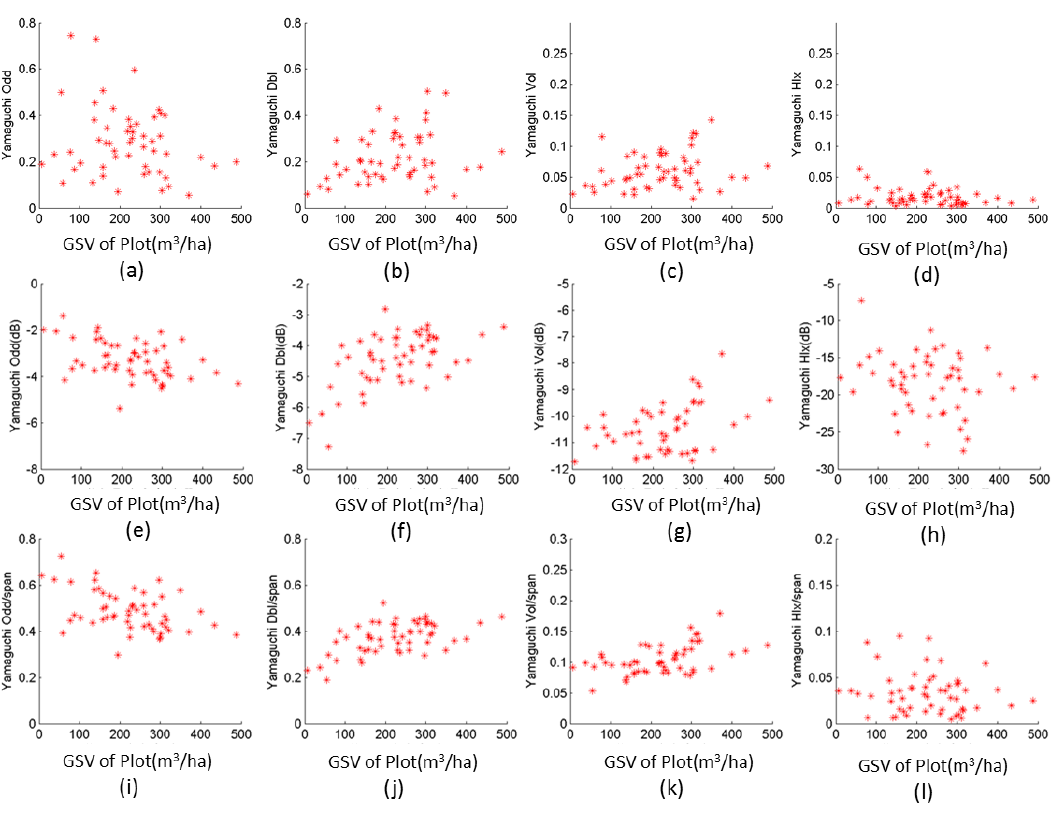
Figure 4. The relationships between the forest GSV and the components obtained by the Yamaguchi decomposition from the image of 30 June 2016: ( a – d ) are the original scattering features; ( e – h ) are decomposition from the image of 30 June 2016: ( a ), ( b ), ( c ) and ( d ) are the original scattering features; the scattering features after the logarithm transformation; ( i – l ) are the scattering features after the ( e ), ( f ), ( g ) and ( h ) are the scattering features after the logarithm transformation; ( i ), ( j ), (k) and ( l ) are ratio transformation. The Odd, Dbl, Vol and Hlx are the surface scattering, double-bounce scattering, the scattering features after the ratio transformation. The Odd, Dbl, Vol and Hlx are the surface volume scattering and helix scattering, scattering, double-bounce scattering, volume scattering and helix scattering, respectively.